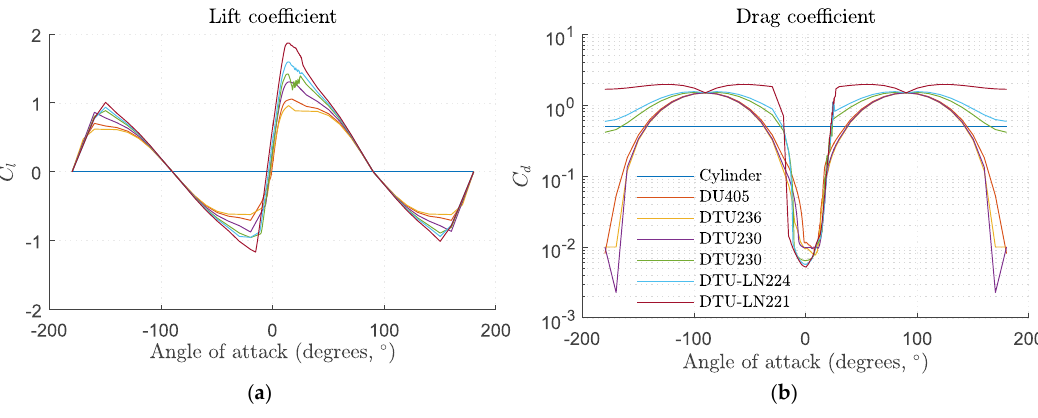
Figure 4. ( a ) Airfoil lift; and ( b ) drag data computed from Q 3 UIC. A smoothing spline and Viterna extrapolation were applied on the airfoil data.